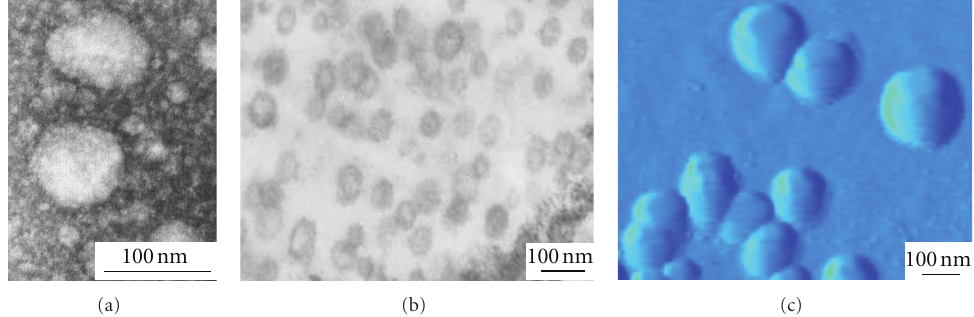
Figure 3: Images of EMVs of A. laidlawii PG8 obtained using transmission, (a, b) and atomic force (c) microscopy. 5 621M M